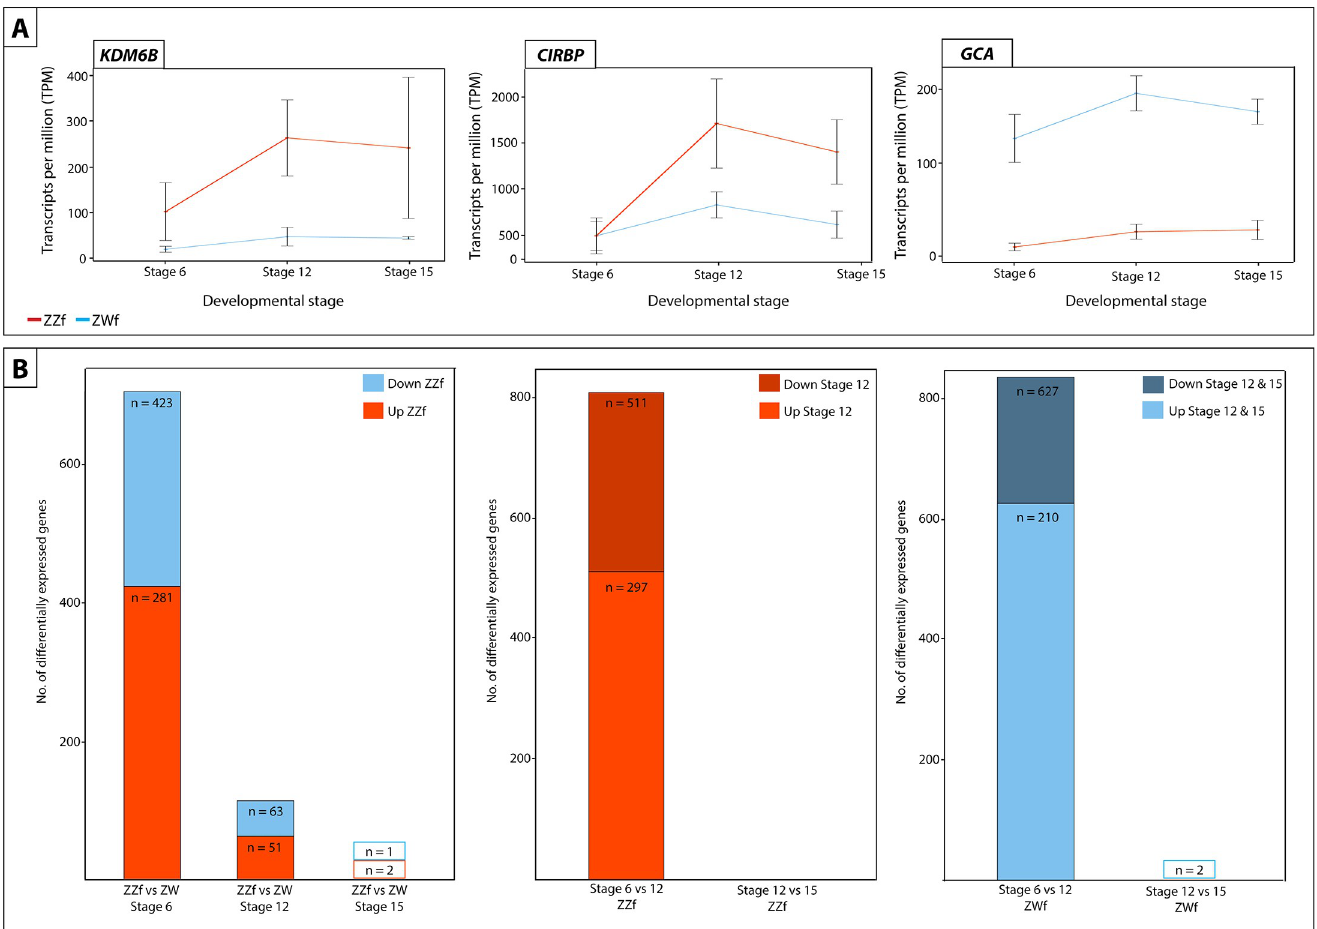
Fig 3. ( A ) Expression (transcripts per million, TPM) ± SE of three genes differentially expressed at all three developmental stages between ZZf and ZWf, with KDM6B and CIRPB (outlined in red) having consistently higher expression in ZZf embryos, and GCA having higher expression in ZWf. ( B ) Bar graphs representing the number of differentially expressed genes in all comparisons between ZZf and ZWf, and between developmental stages. MA plots of this data are available in S1 Fig. Differentially expressed genes were determined as having P values � 0.01 and log 2 -fold changes of 1,